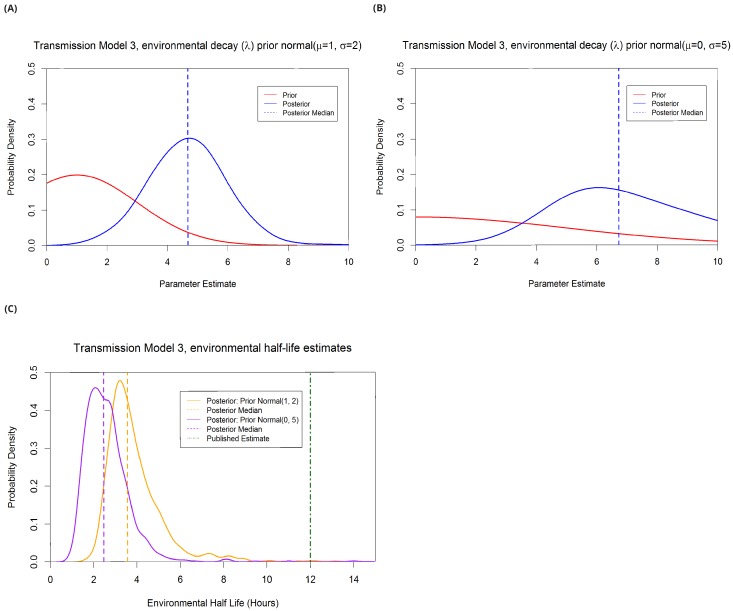
Estimation of λ from transmission model 3 under different prior assumptions.The more informative prior, half-normal(µ=1, σ=2), gave a median parameter estimate of 4.7 (panel A) corresponding to an environmental half life of 3.6 hours (panel C). The less informative prior, half-normal(µ=0, σ=5), gave a median parameter estimate of 6.7 (panel B) corresponding to an environmental half life of 2.5 hours (panel C). The only published estimate of resistant Klebsiella pneumoniae half life on surfaces is 12 hours (λ=1.39, see Methods), therefore the informative prior gives more weight to biologically plausible values of λ. The qualitative interpretation of the model (that environmental contamination with K. pneumoniae decays quickly) is unchanged with either prior, as is WAIC.